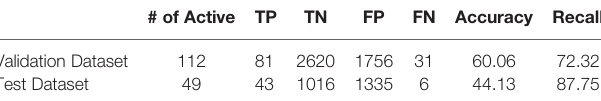
FIGURE 3 | Area Under the Receiver operation Characteristic Curve (AUC) scores of the model during training. The model is evaluated on the training and augmented validation dataset at the end of each epoch. The model starts to over- fi t after 2 epochs. TABLE 3 | Results of the trained model.